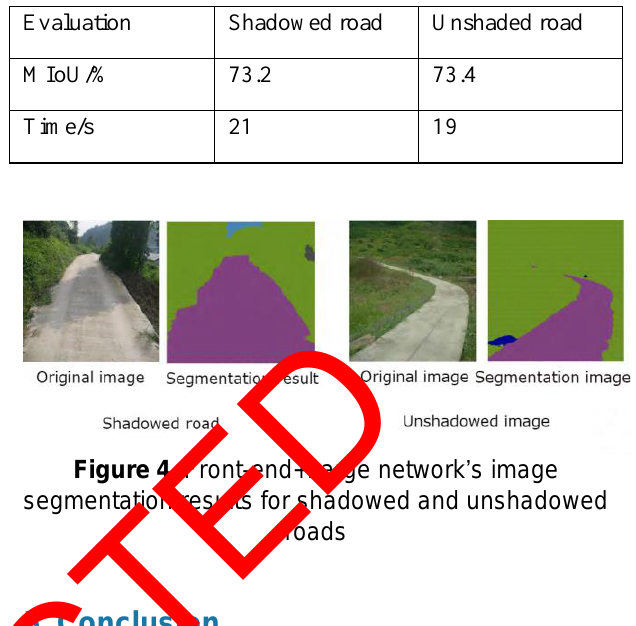
Figure 2. Segmentation result(from top to bottom, Input image, marked true value, predicted value)